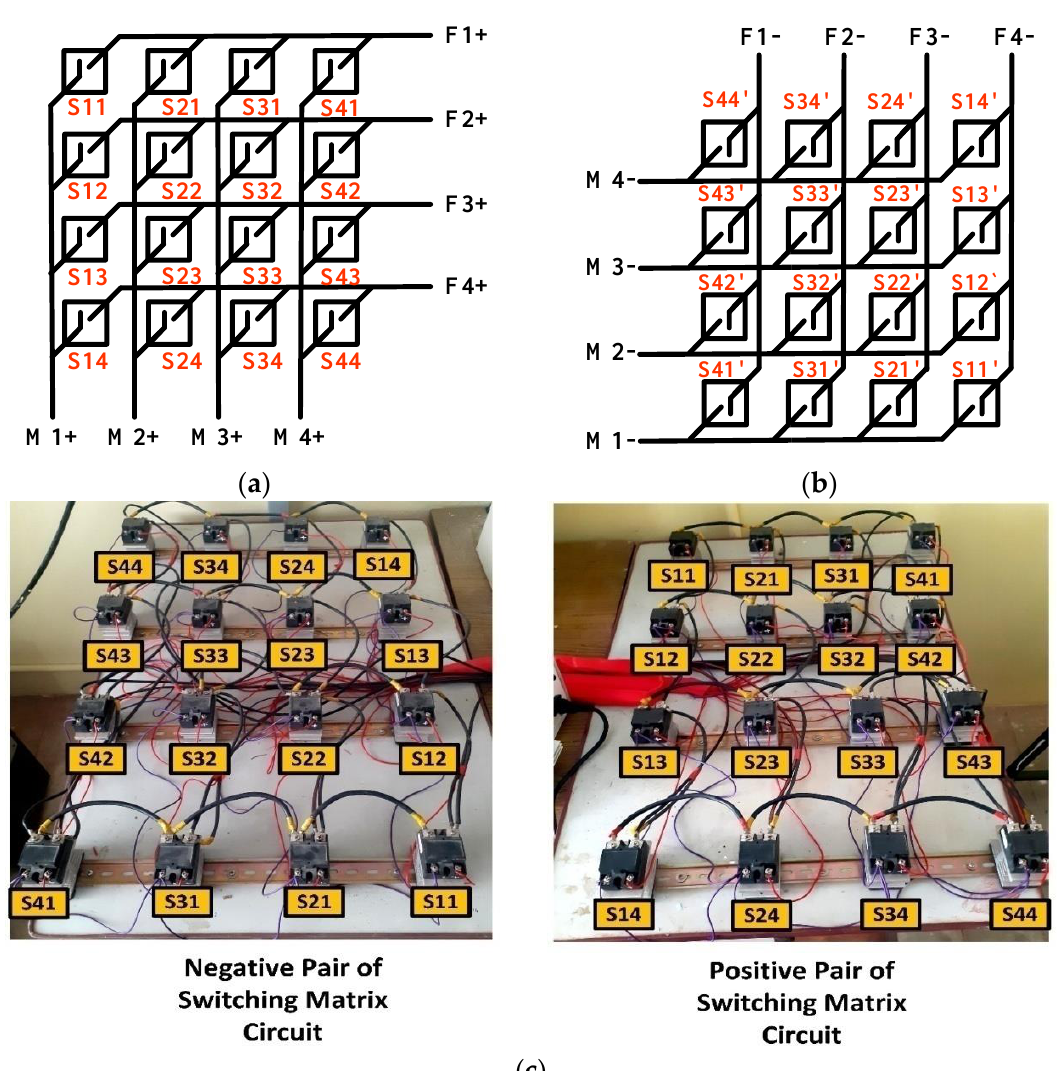
Figure 7. ( a ) Positive pair of switching matrix circuit; ( b ) negative pair of switching matrix circuit; ( c ) photograph of the switching matrix circuit. The switching representation is given below in Table 2. Table 2. Details of switching circuit.